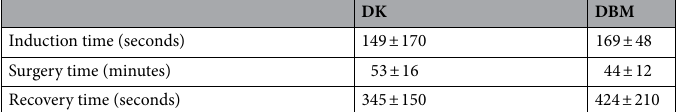
Table 2. Induction time, surgery time and recovery time in 20 Egyptian fruit bats anaesthetized for gonadectomy. Bats in group DK (n = 10) received dexmedetomidine (DEX) and ketamine (KET) combination and bats in group DBM (n = 10) received DEX, butorphanol (BUT) and midazolam (MDZ) administration. Atipamezole (group DK) or atipamezole and flumazenil combination (group DBM) was administered intramuscularly at the end of the surgery. Results are presented as mean ± standard deviation.